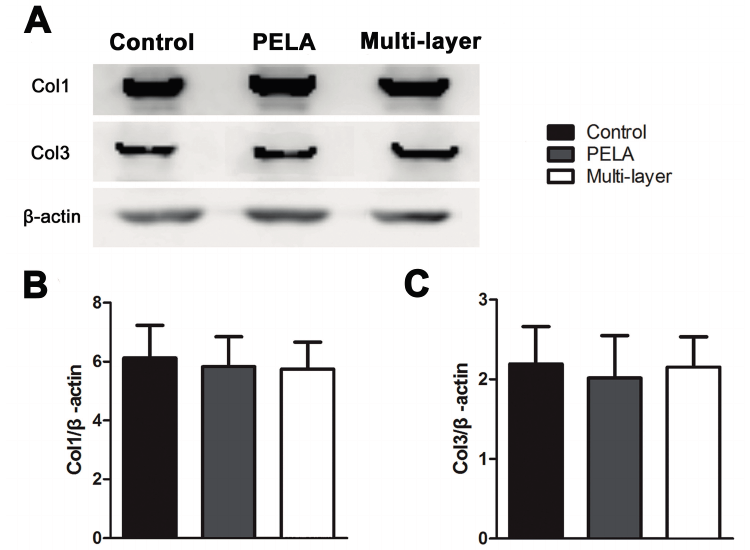
Figure 4. Western blotting assay for collagen I and collagen III expression in repair sites with the untreated group, PELA fibrous membrane group, and multi-layer fibrous membrane group for three weeks ( A ). Densitometry of collagen I ( B ) and collagen III ( C ) from Western blot experiment. Data are expressed as mean ± SEM for six